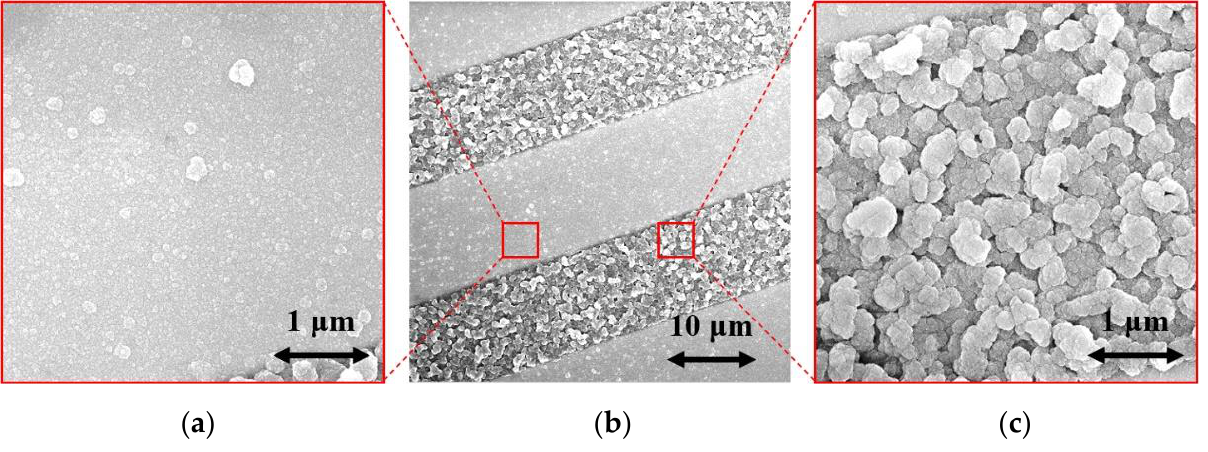
Figure 6. SEM images of ( a ) NCD on electrode, ( b ) NCD on IDT structure, and ( c ) NCD on glass.